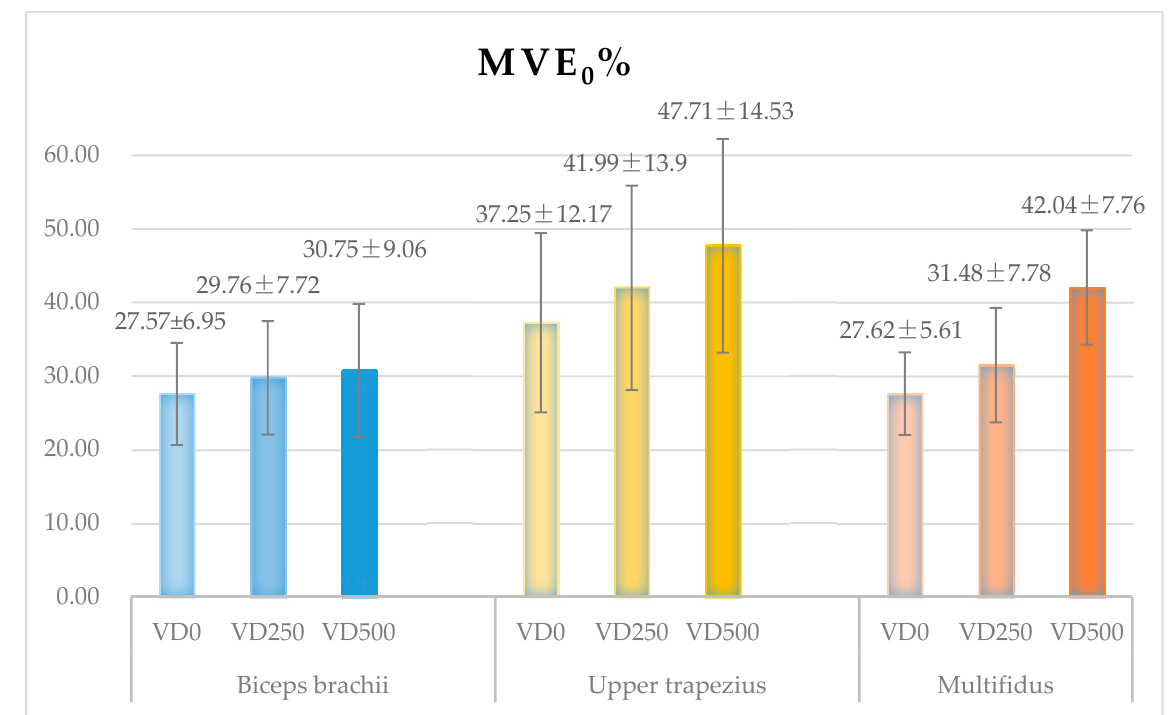
Figure 7. The tension values (MVE 0 %) of target muscles (biceps brachii, upper trapezius, multifidus), combined all the subjects, in three tested tasks.